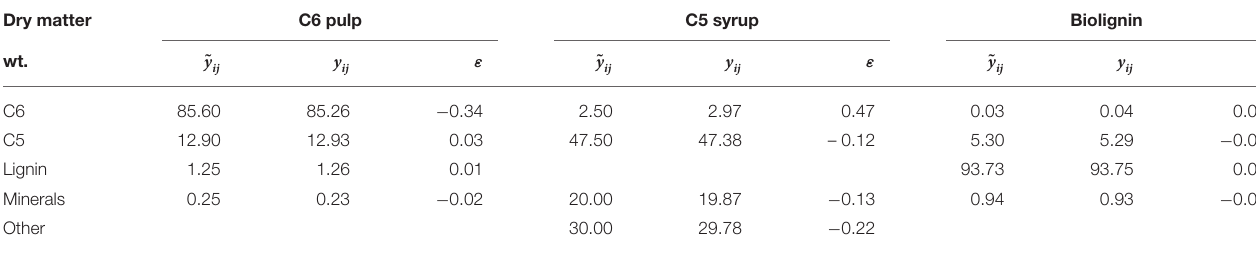
TABLE 3 | Results for the product streams (wheat